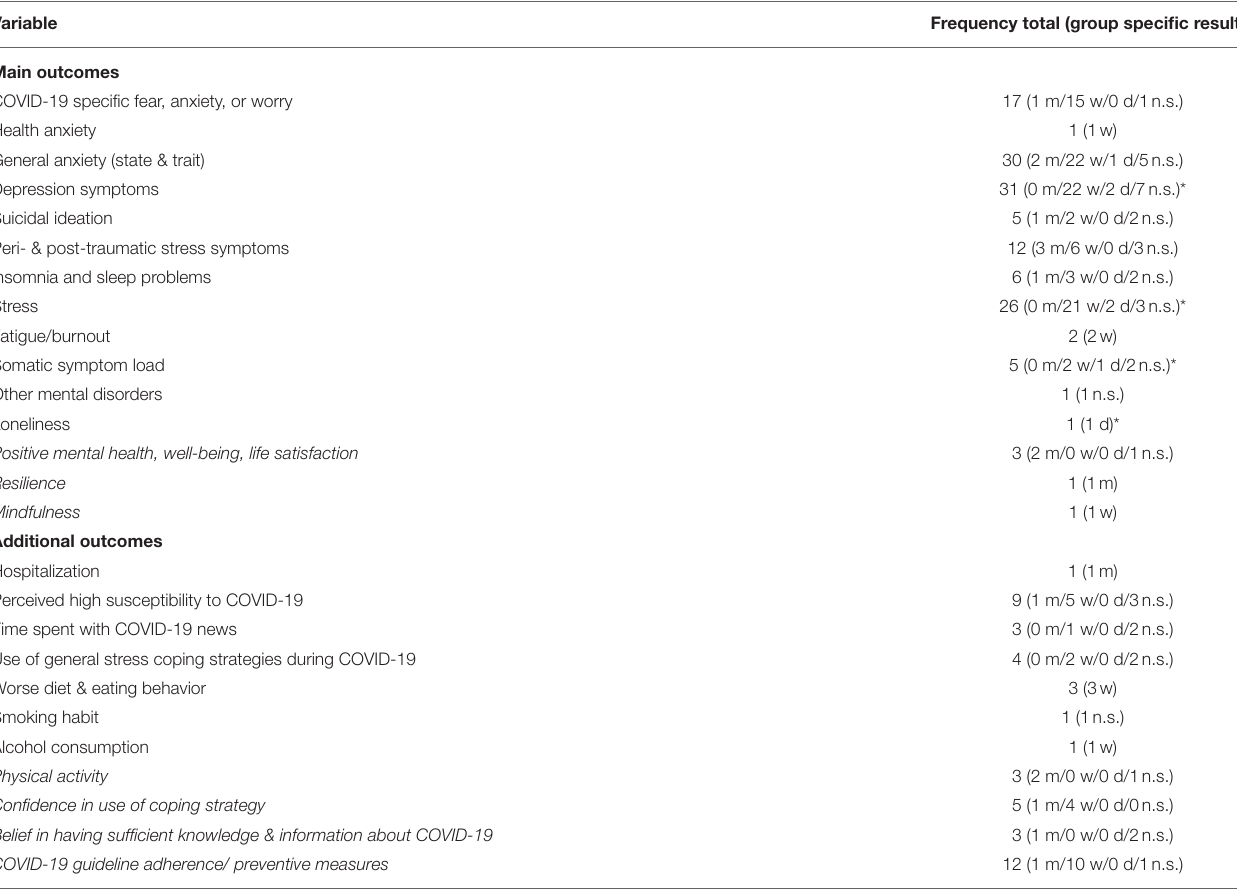
TABLE 1 | Overview of sex- and gender-stratified assessed outcome variables in all studies.